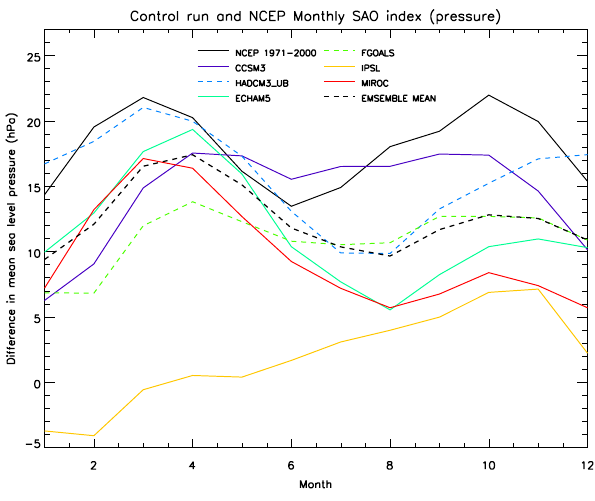
Fig. 3. Another measure of the SAO index ( 1 SLP) for NCEP data and all of the available and stable models (see Braconnot et al., 2007) from the PMIP2 control run (hPa). Refer to Table 1 for more details on each